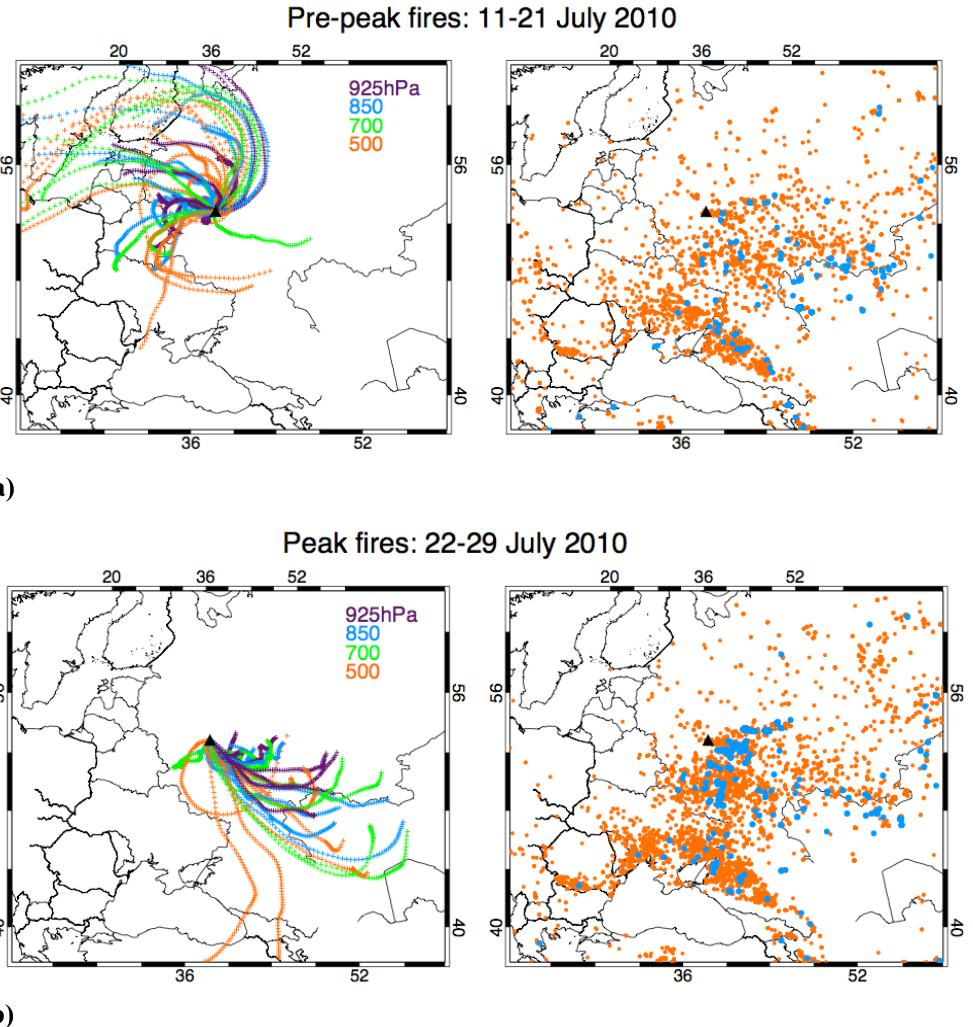
Fig. 3. Left-hand column are three-day back-trajectories initiated from Moscow (solid black triangle). Trajectories were initialized at 12:00Z. Pressure levels are plotted at 925hPa (purple), 850hPa (blue), 700hPa (green), and 500hPa (orange) for five time periods between July and August 2010. The time interval between the cross symbols is 15-min. The right-hand column shows the MODIS (combined Aqua and Terra) fire counts (red) and FRP greater than 200MW (blue) for the same five time periods.